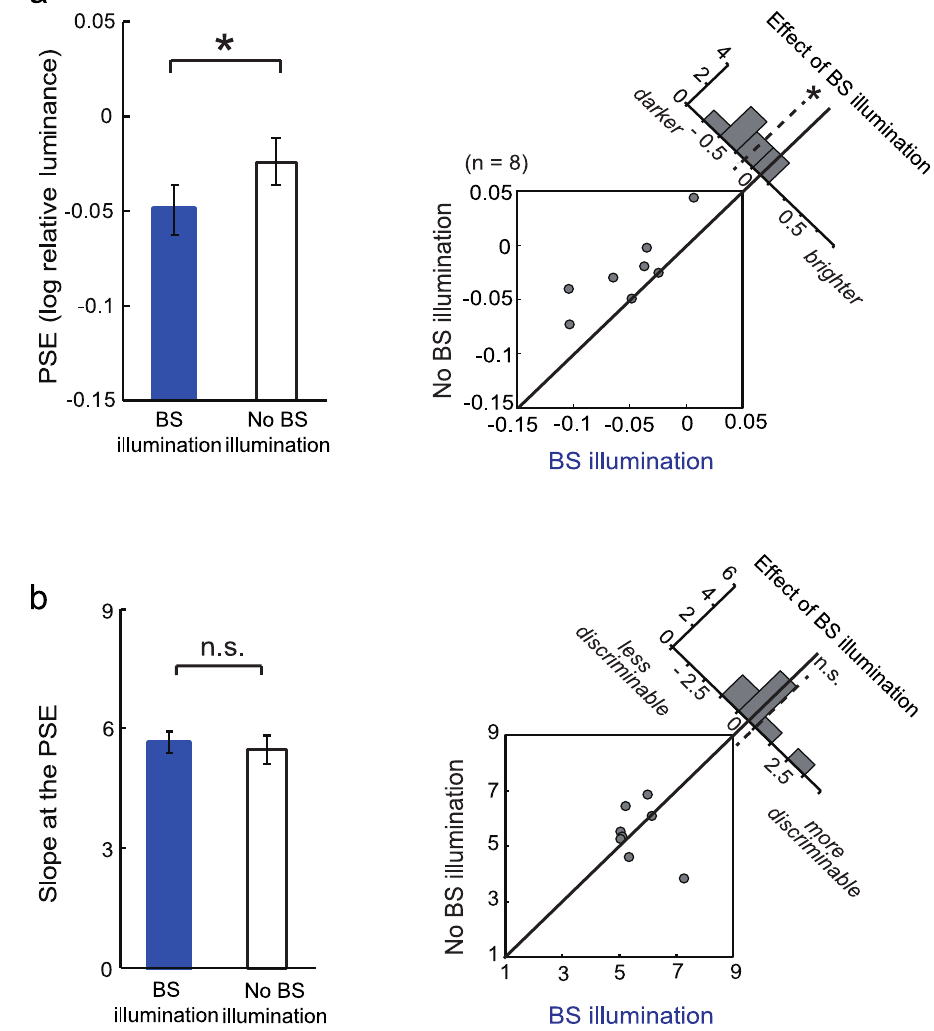
Figure 2. Results of Experiment 1 demonstrating brightness decrease by illumination inside the blind spot (BS). ( a ) Results of the brightness matching. Point of subjective equality (PSE) (n = 8; mean ± standard error) is plotted as an index of brightness in the two conditions. The right-hand panel depicts an interobserver scattergram, as well as a histogram of the difference in PSE between the two conditions; negative values indicate that the test arc appeared darker with BS illumination than without it. * p < 0.05. ( b ) Slope of the psychometric function plotted for the two conditions. The right-hand panel shows an interobserver scattergram, as well as a histogram following the same convention as in ( a) . n.s.: not